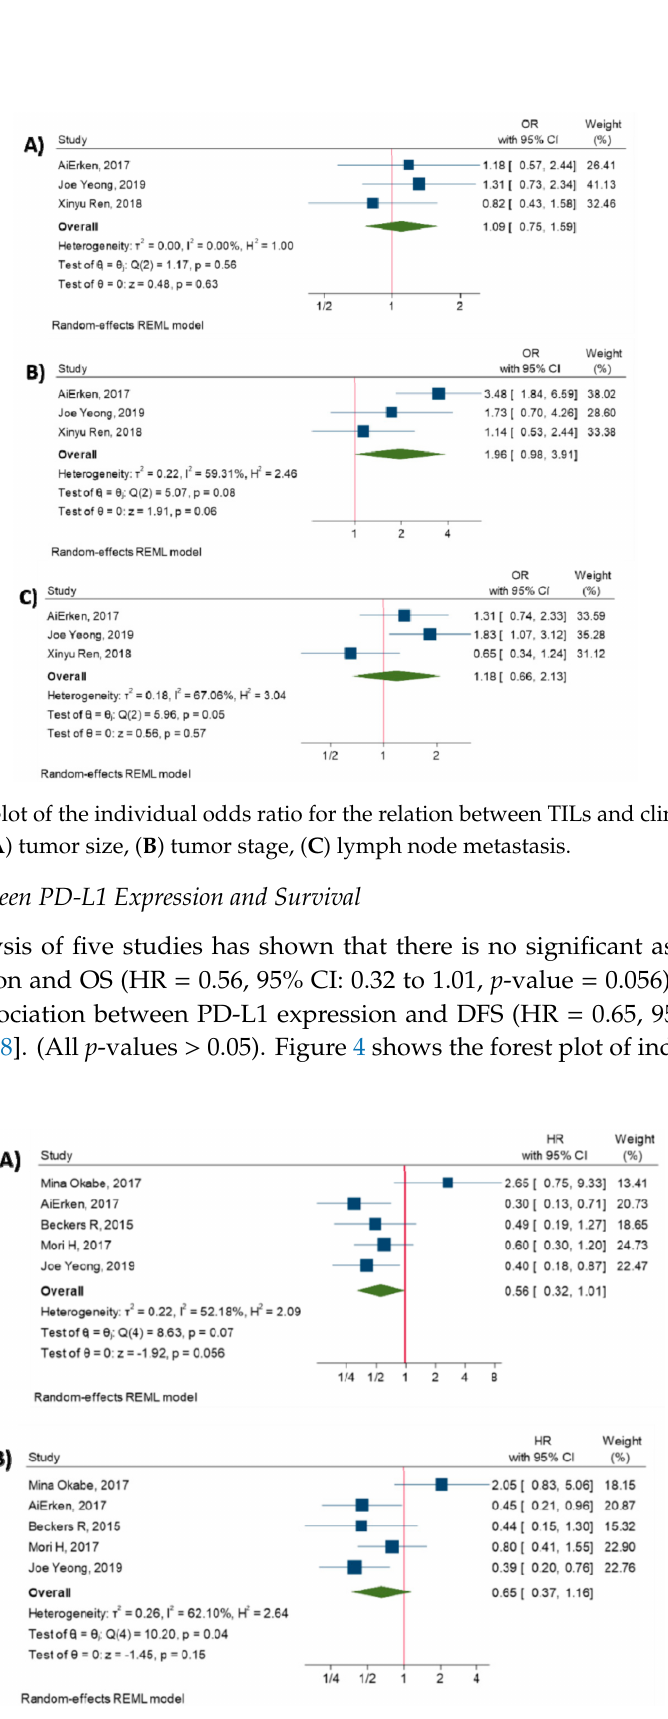
Figure 4. Forest plot of individual relative risks for PD-L1 expression-related survival. ( A ) OS. ( B )